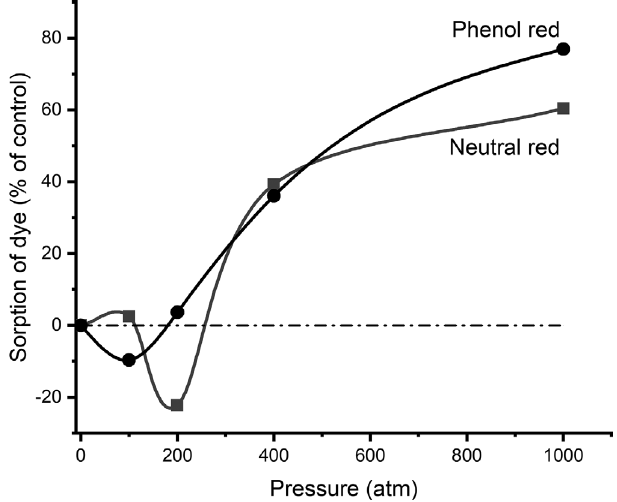
Fig. 2. Binding of the vital dyes by sartorius frog muscle during the action of hydrostatic pressure ([12], Figs. 20, 21,